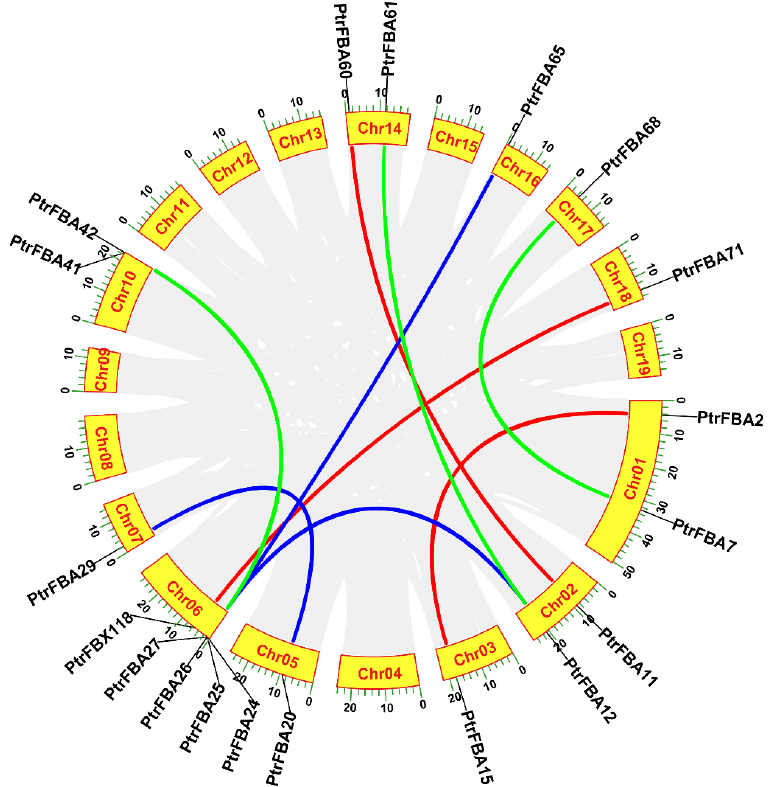
Figure 4. Evolutionary relationship analysis of the PtrFBAs gene family. Evolutionary analysis of the PtrFBAs gene family in P. trichocarpa , with different sizes of fan-shaped rings and different sizes of chromosomes. The gray lines in the background represent collinear blocks of the genome and the colored lines represent paralog PtrFBA gene pairs.